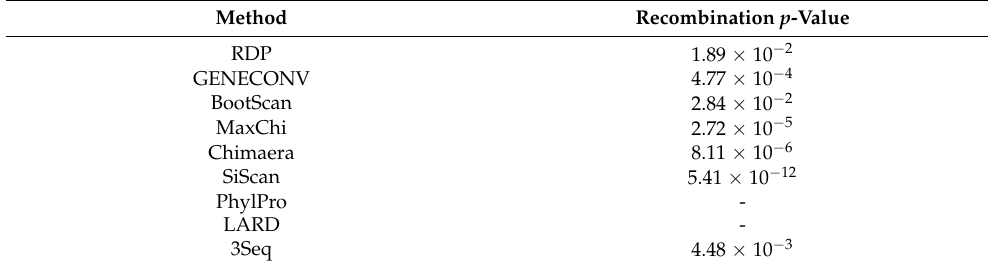
Table 7. Recombination statistics of Vietnam/VNUA-26/2021 Cap gene sequence using RDP 4.